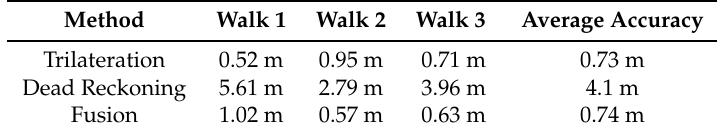
Figure 12. The detected walking paths without context information. Table 19. Positioning accuracy of final position after each trial without considering the context